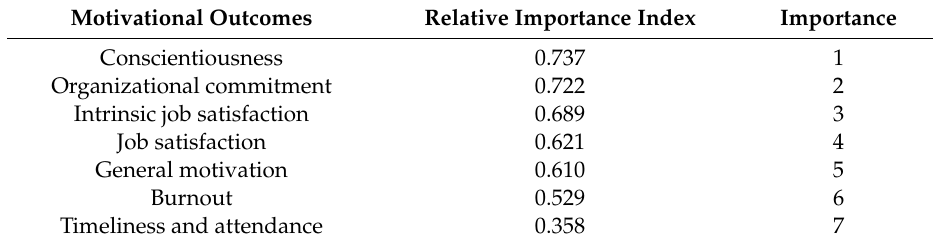
Table 3. Relative importance of motivation outcomes among healthcare professionals ( N = 553).